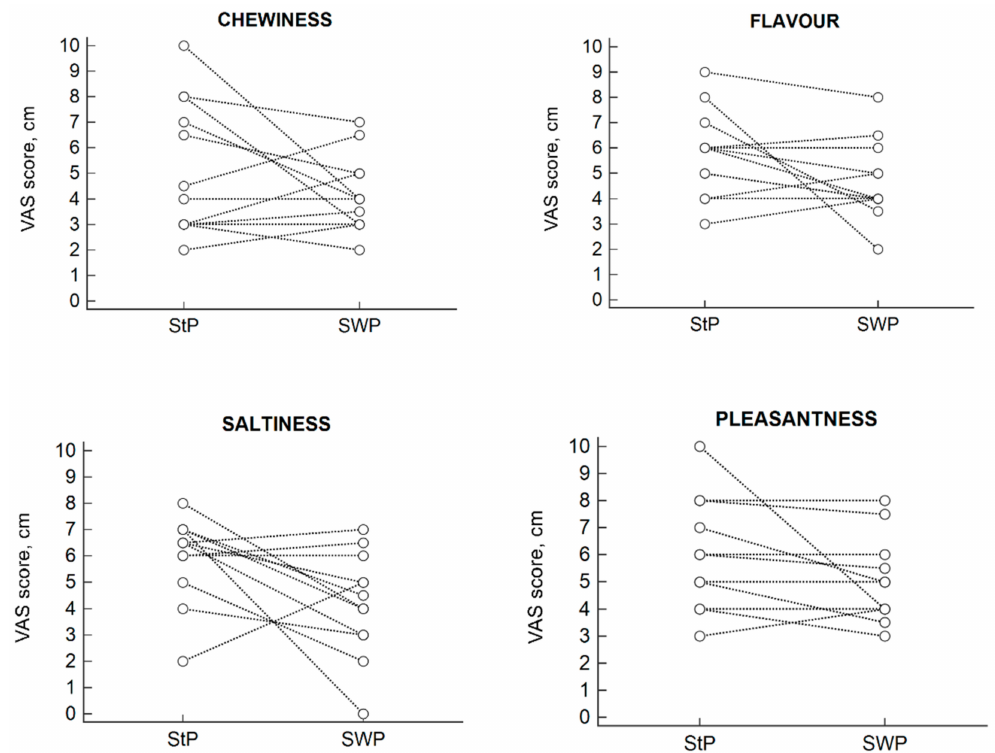
Figure 2. Individual visual analogue scale (VAS) scores for the four factors analysed: chewiness, flavor, saltiness,